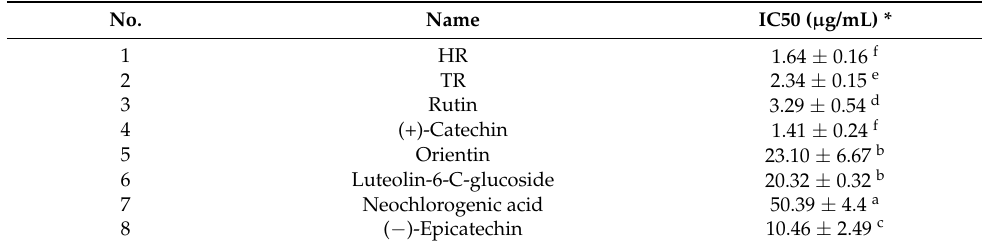
Table 7. Results of DPPH free-radical scavenging